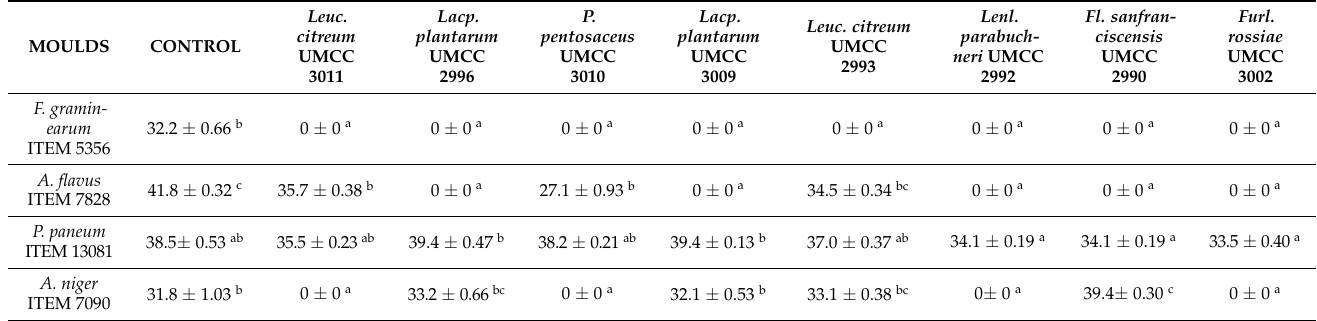
Table 2. Activity of eight lactic acid bacteria strains against the tested moulds.